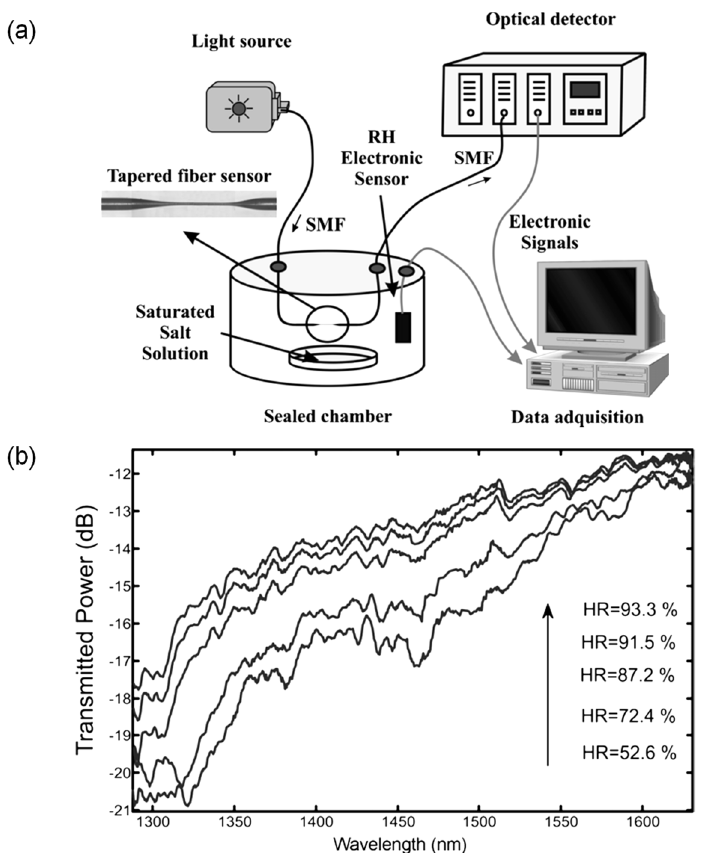
Figure 11. Point sensor. ( a ) Experimental setup. ( b ) Spectral response to different levels of RH. Reprinted with permission from [47] © Elsevier . Adapted with permission from ref. [47]. Copyright 2007 Elsevier